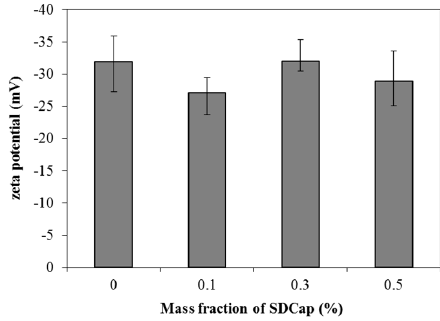
Figure 9. Variations of zeta potential as a function of concentration of SDCap.